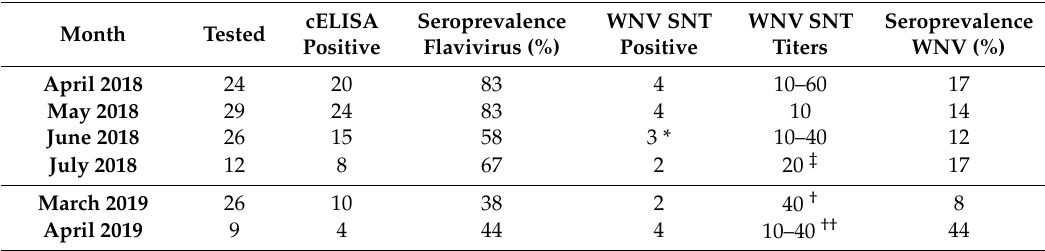
Table 2. Results of the cross-sectional serosurveys carried out in magpies in 2018 and early 2019 for the detection of WNV